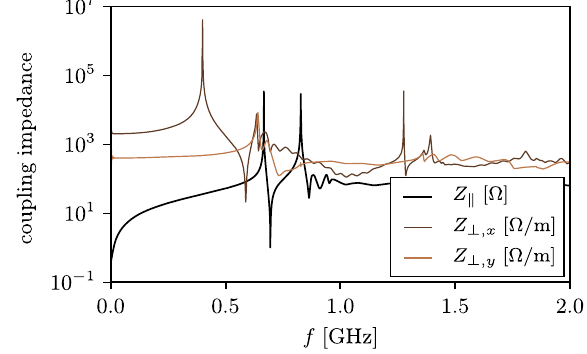
FIG. 6. Longitudinal and transverse beam coupling impedances of the WOWCC.